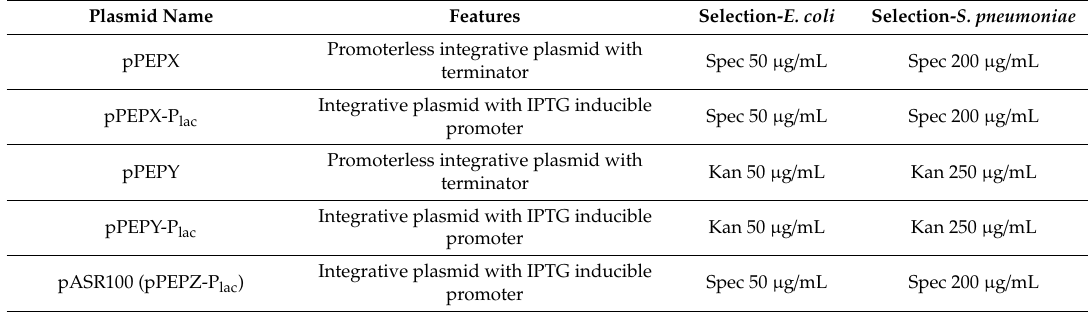
Table 1. List of constructed plasmids. Spec-spectinomycin, Kan-Kanamycin,